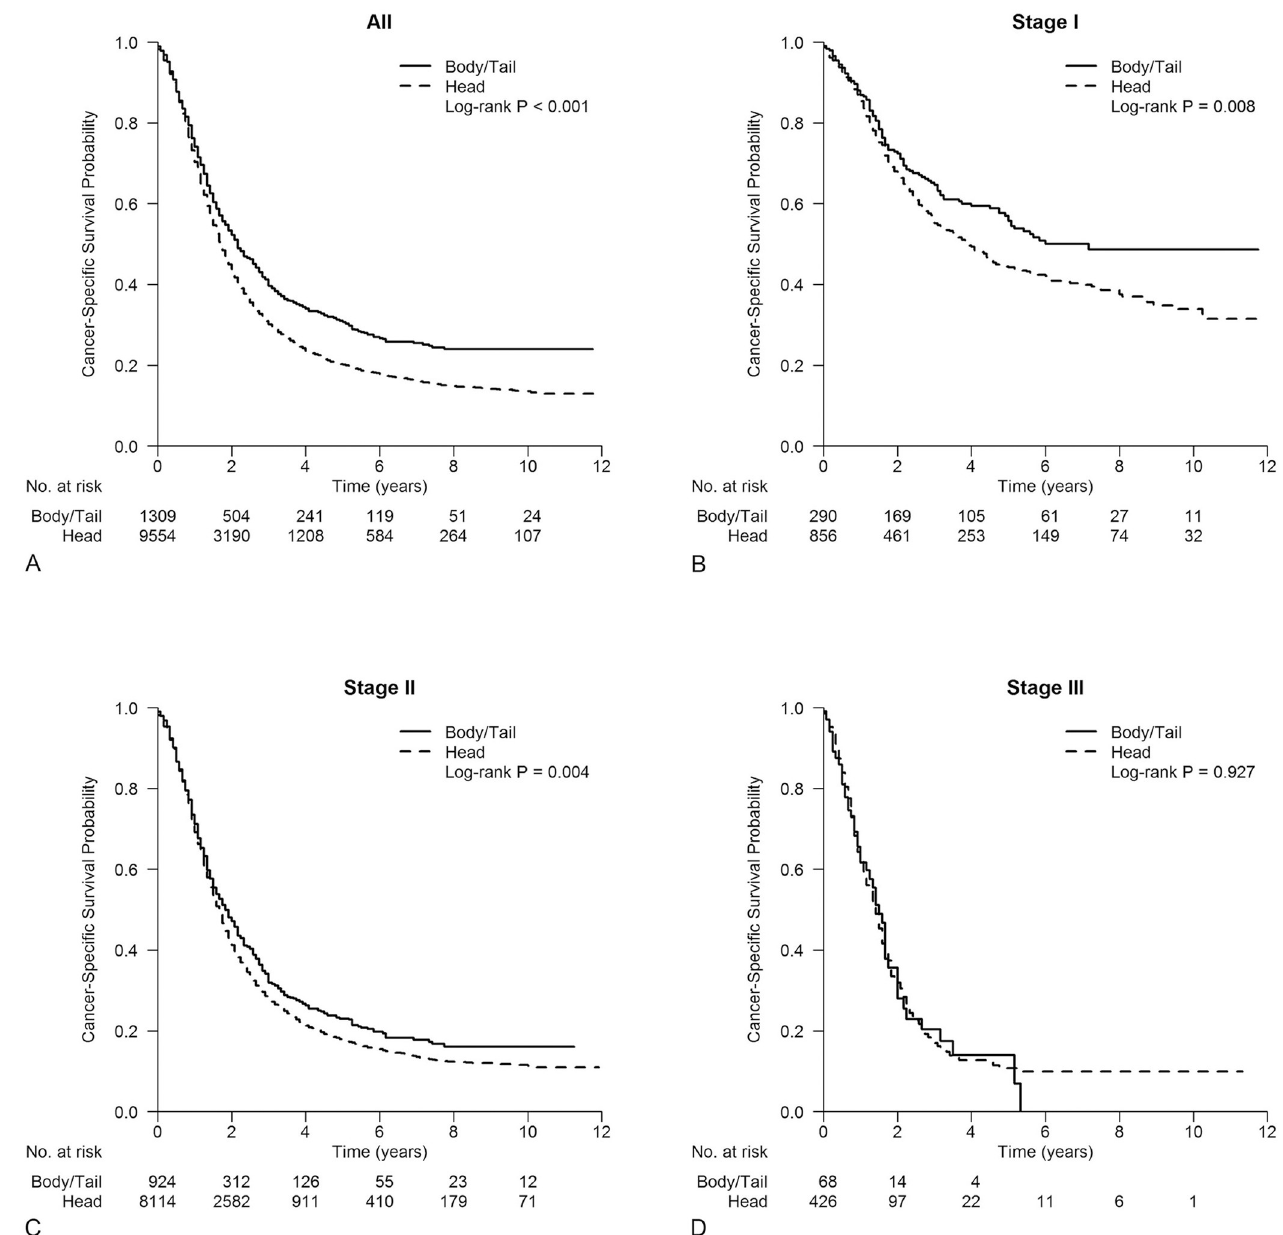
Fig 1. Kaplan-Meier survival analysis for patients with PHC and PBTC. A: All stages combined (P < 0.001); B: stage I (P = 0.008); C: stage II (P = 0.004); D: stage III (P = 0.927).